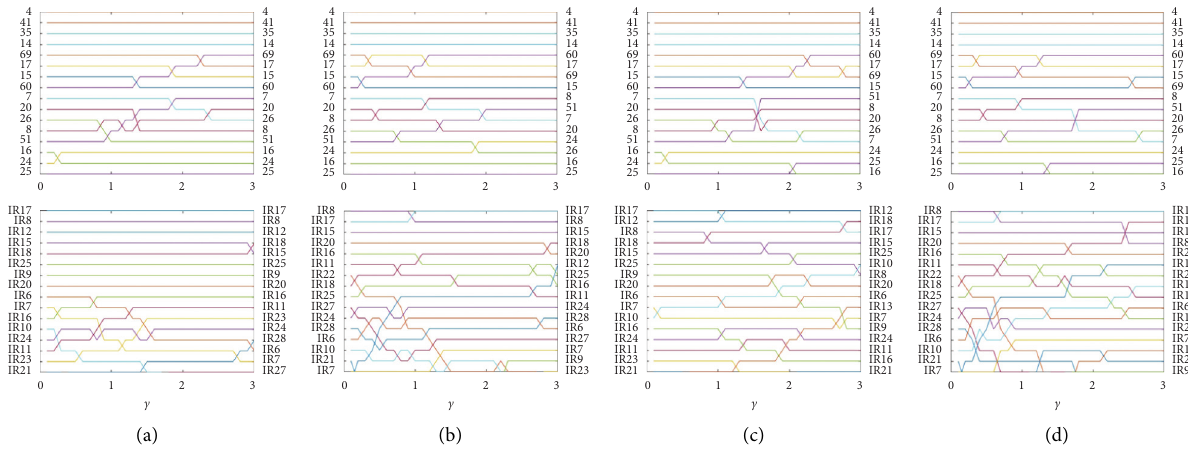
Figure 20: Multiplex MultiRank calculations. The first row corresponds to the node’s ranking and the second one to the layers. Every graph shows the results for the parameter c between 0 and 3. (a) Elite layers have more weight and the influence of each layer is required to be independent of W α . (b) Elite layers have more weight and centralities of the layers are not normalized by W α . (c) Popular layers are more influential and this influence is independent of W α . (d) Popular layers are more influential and centralities are not normalized by W α